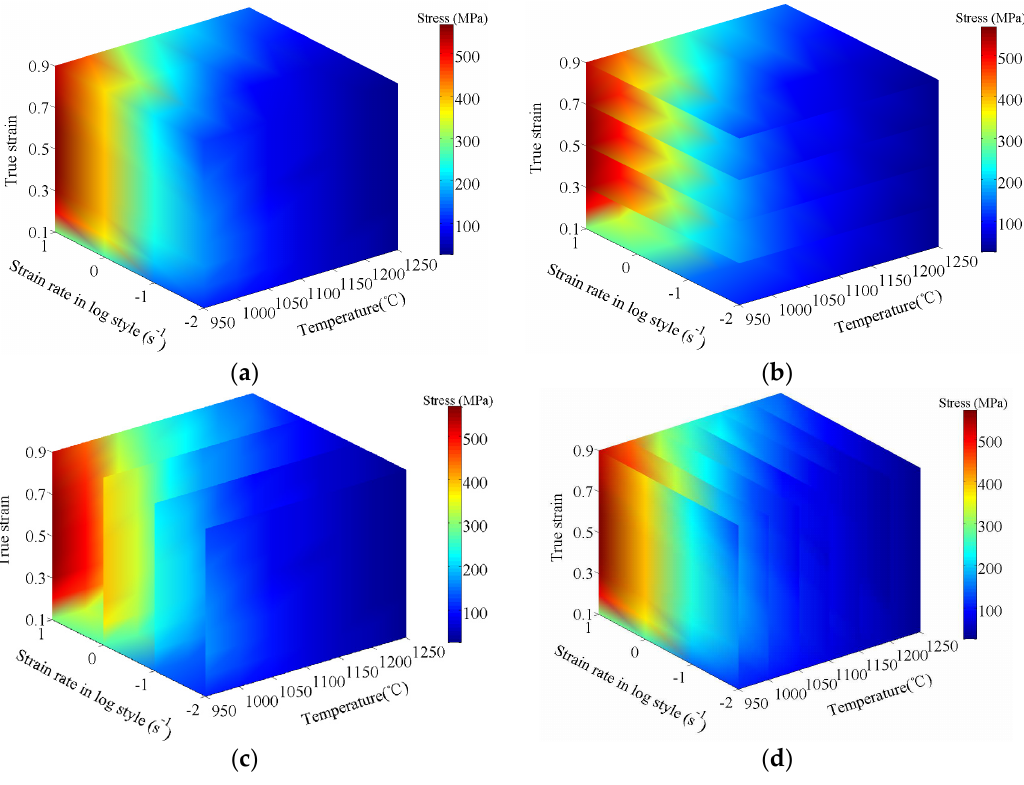
Figure 10. The 3D relationships among temperature, strain rate, strain and stress: ( a ) 3D continuous interaction space, 3D continuous mapping relationships under different ( b ) temperatures; ( c ) strain rates and ( d ) strains.